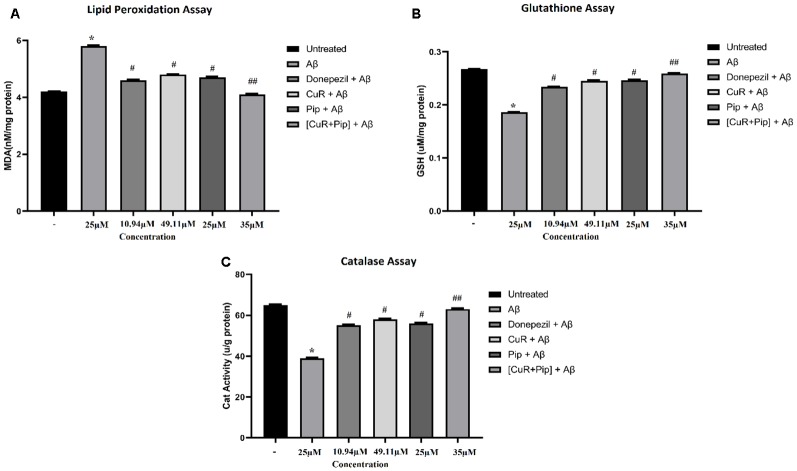
Biochemical assay of SH-SY5Y cells treated with Aβ, Donepezil + Aβ, curcumin + Aβ (CuR + Aβ), piperine + Aβ (Pip + Aβ), and combined curcumin and piperine + Aβ [(CuR + Pip) + Aβ]. (A) Lipid peroxidation assay, (B) glutathione assay, (C) catalase assay. Values were presented as mean ± SD, from three independent experiments. *p < 0.01, compared to untreated group. #p < 0.05, ##p < 0.01, compared to the Aβ group (one-way ANOVA followed by Tukey’s test). MDA, malondialdehyde; GSH, glutathione; Cat, catalase.